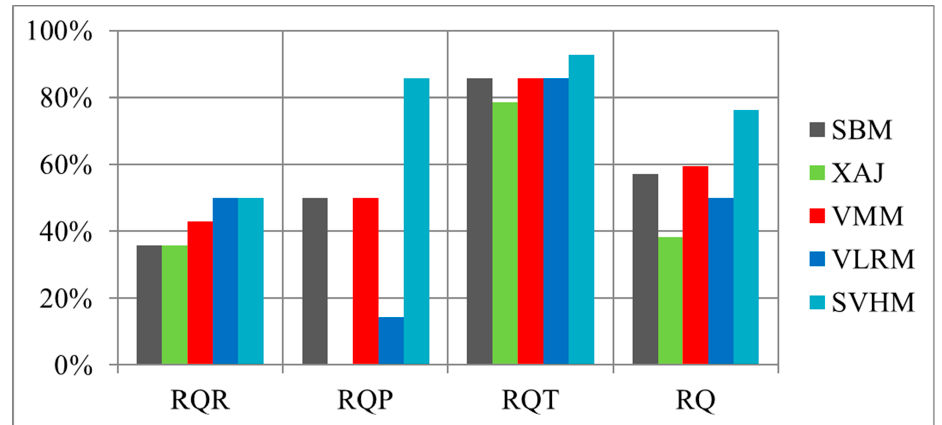
Figure 12. Comparisons of performance measures for different models in simulating all flood events in Chutoulang Basin (Note: RQR, RQP and RQT denote the ratio of qualified total runoff, ratio of qualified flood peak and ratio of qualified appearance time for flood peak, respectively. RQ is the mean of RQR, RQP and RQT. RQ can be classified by A grade: 85–100%, B grade: 70–85% and C grade: 60–70% [36] .